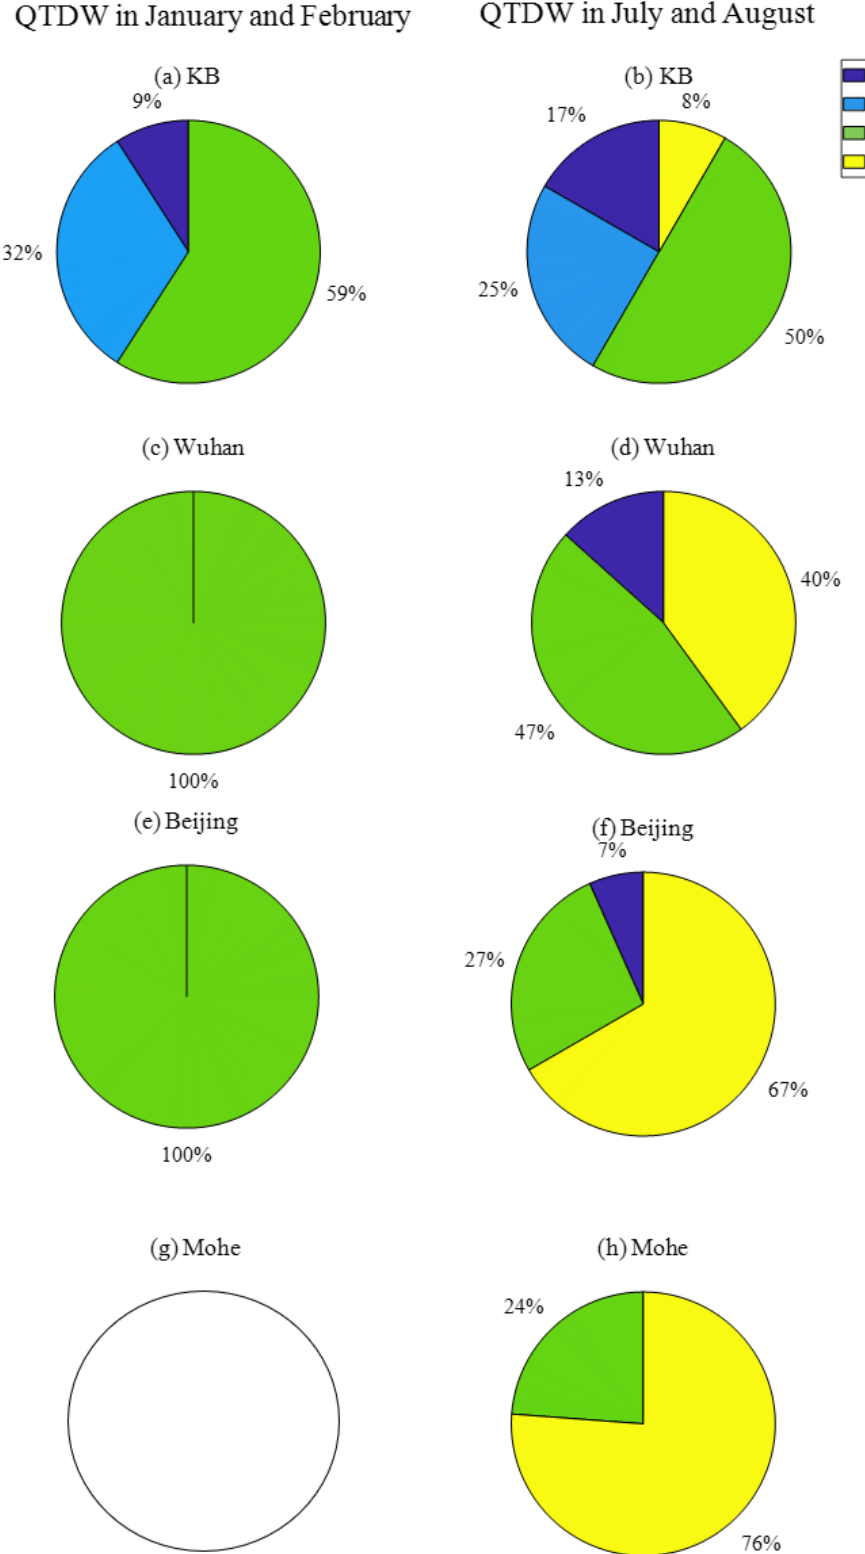
Figure 9. The wavenumber statistics of QTDW events in January and February over ( a ) KB from 2003 to 2012, ( c ) Wuhan, ( e ) Beijing, and ( g ) Mohe from 2011 to 2019. The wavenumber statistics of QTDW events in July and August over ( b ) KB from 2003 to 2012, ( d ) Wuhan, ( f ) Beijing, and ( h ) Mohe from 2011 to 2019. The white color in ( g ) represents no QTDW events in January and